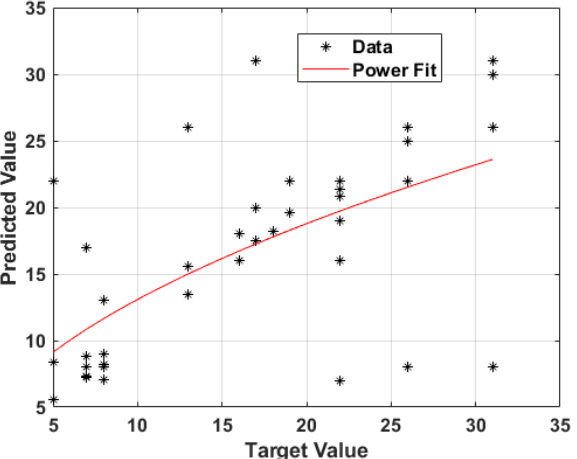
Figure 9. System failure plot of target vs. predicted value for ES Model training.